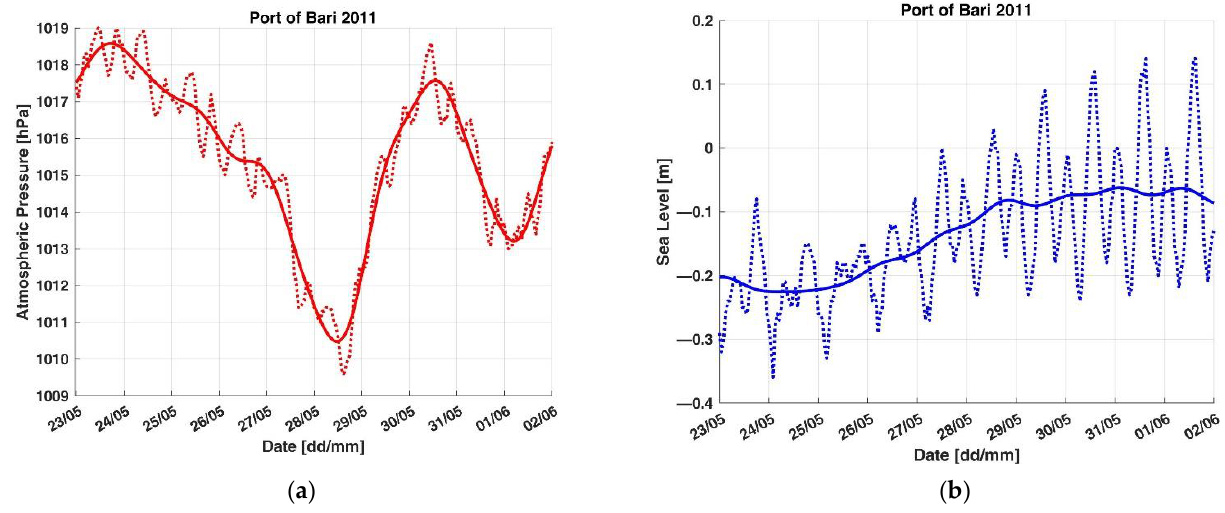
Figure A12. Low-frequency components of meteo-mareographic parameters acquired by ISPRA’s monitoring station in the port of Bari from 23 May to 2 June 2011: ( a ) atmospheric pressure; ( b ) sea level.